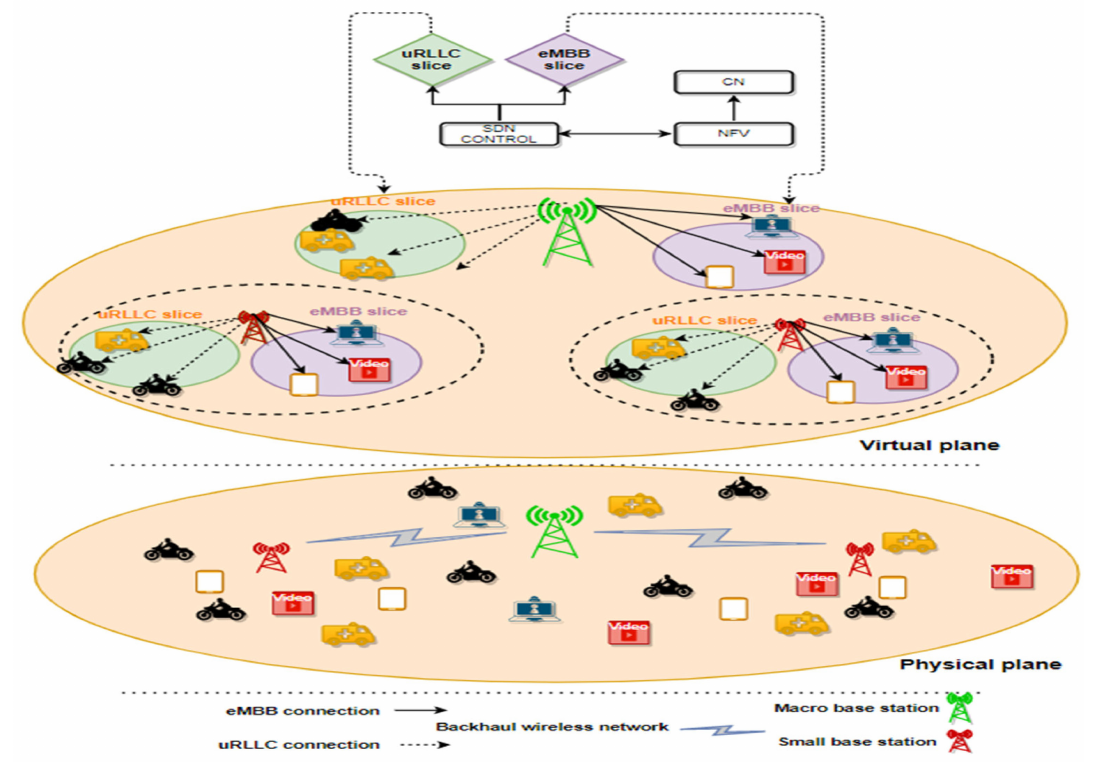
Figure 2. System